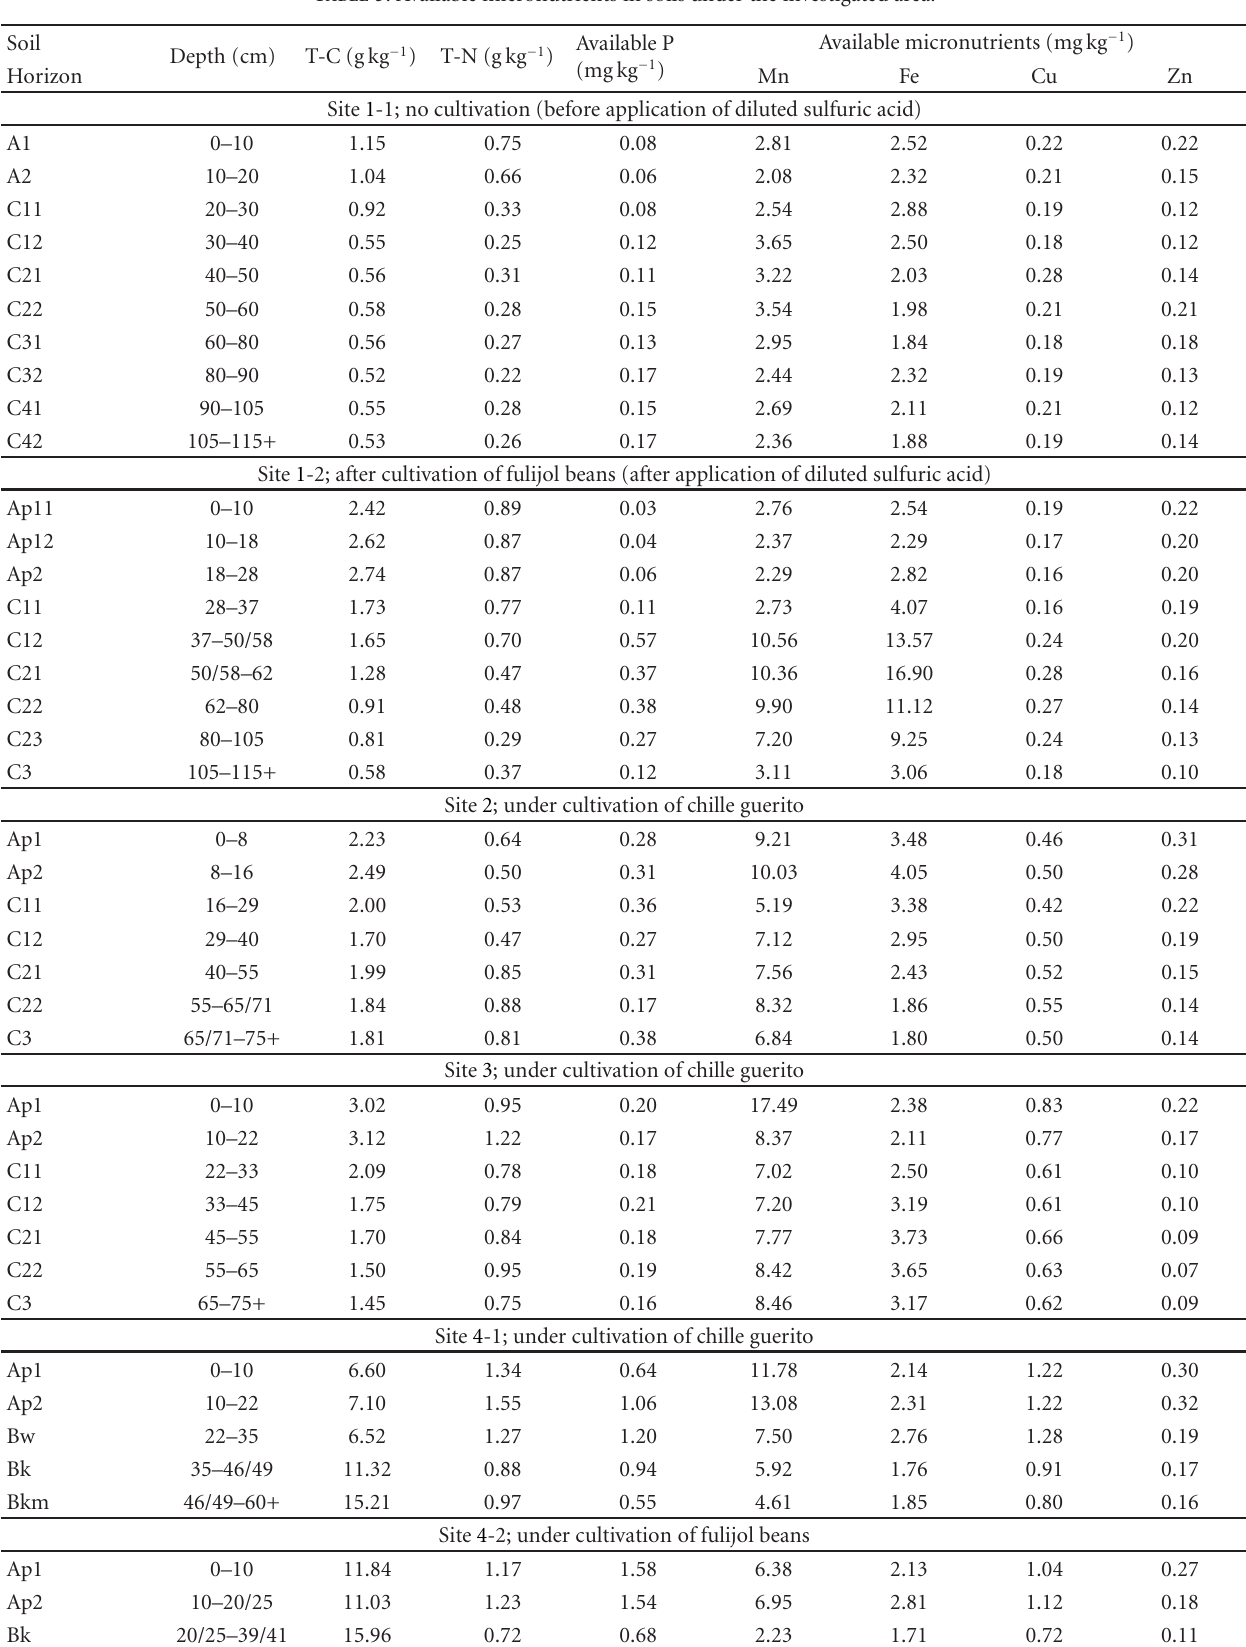
Table 5: Available micronutrients in soils under the investigated area.